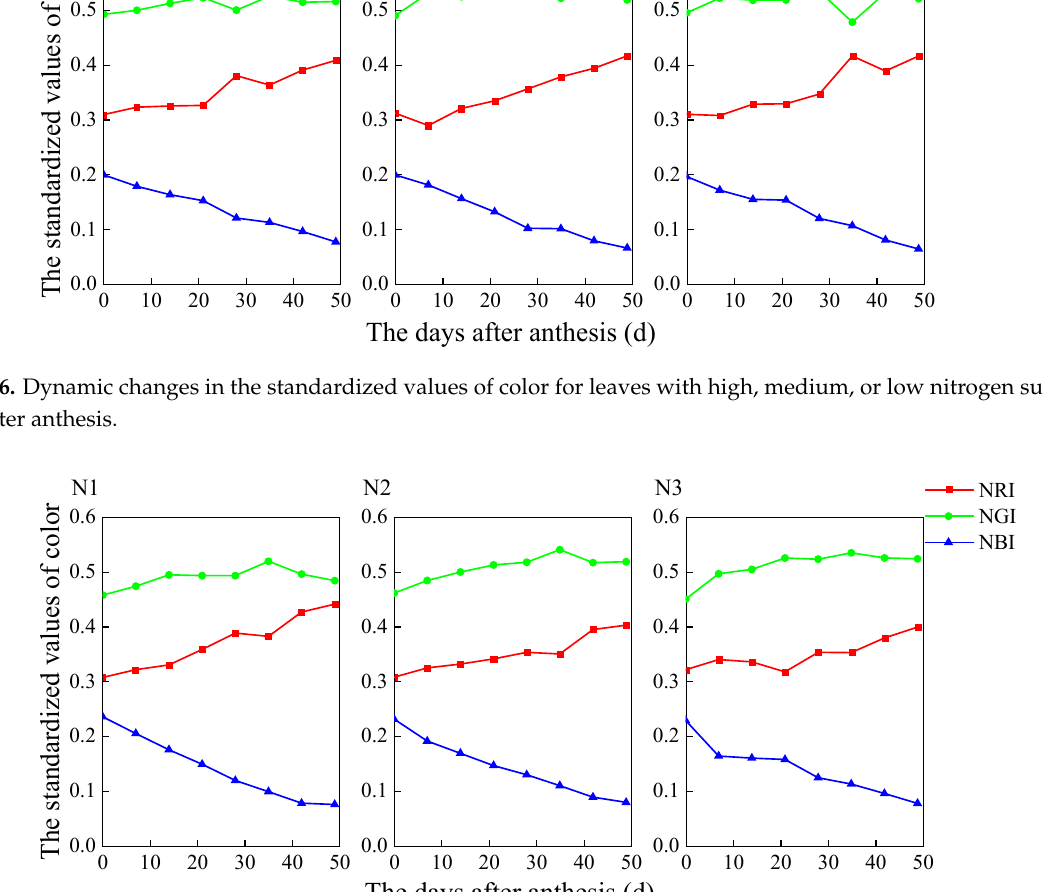
Figure 7. Dynamic changes in the standardized values of color for leaves with high, medium, or low nitrogen supplies in YJ4227 after anthesis.